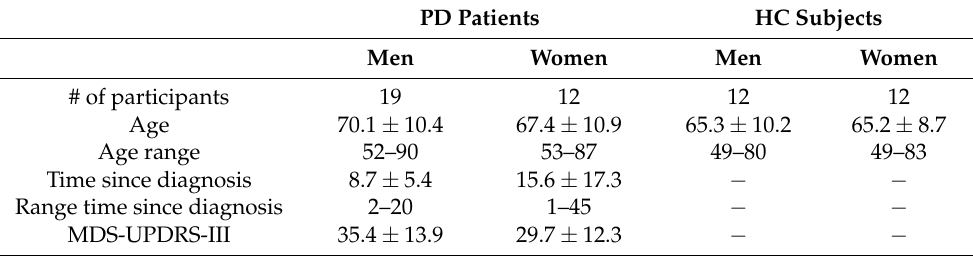
Table 1. Demographic information of the patients and healthy controls considered in this